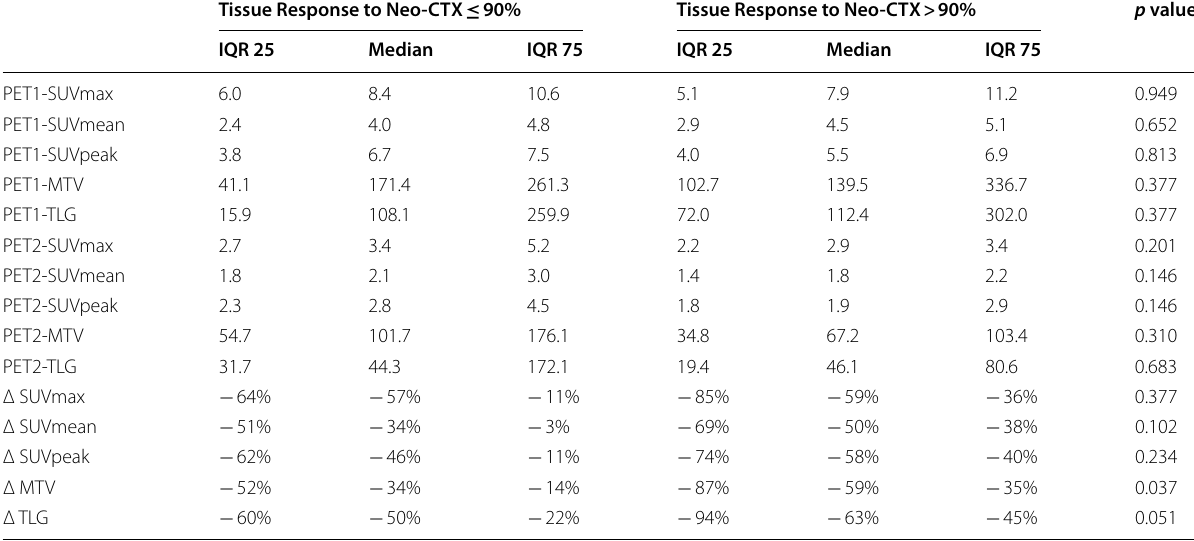
Table 4 [ 18 F]FDG PET parameters and response to neoadjuvant CTX. ΔMTV parameter was significantly associated with pathological response to Neo-CTX (Mann–Whitney test). IQR: interquartile